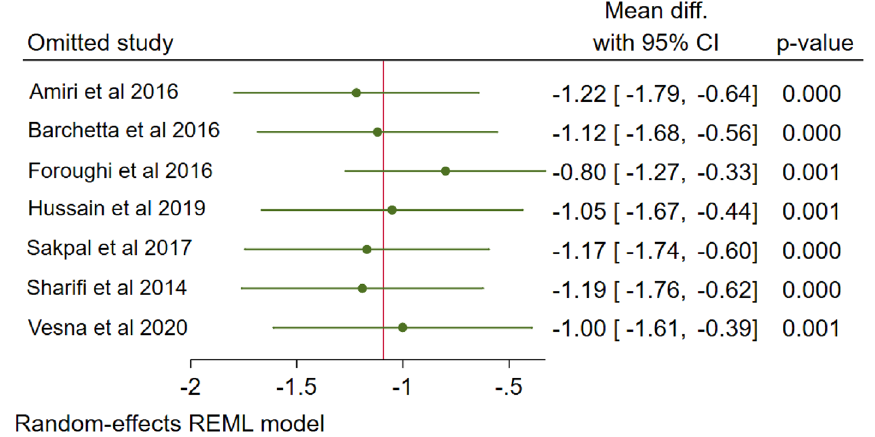
Figure 7. Sensitivity analysis by leave-one-out method, omitting each